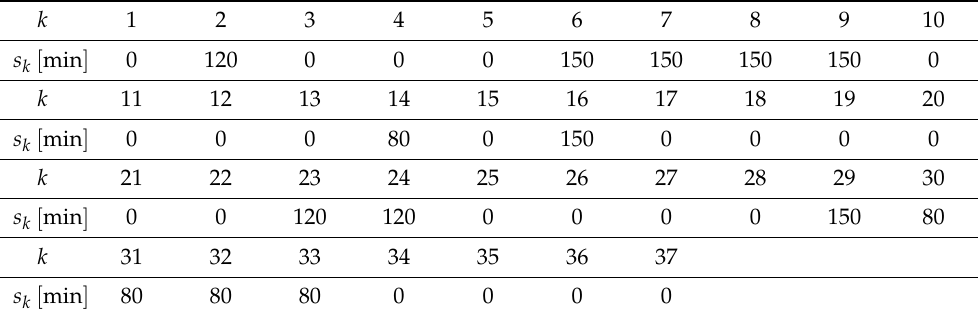
Table 10. Input values of the constant s k .